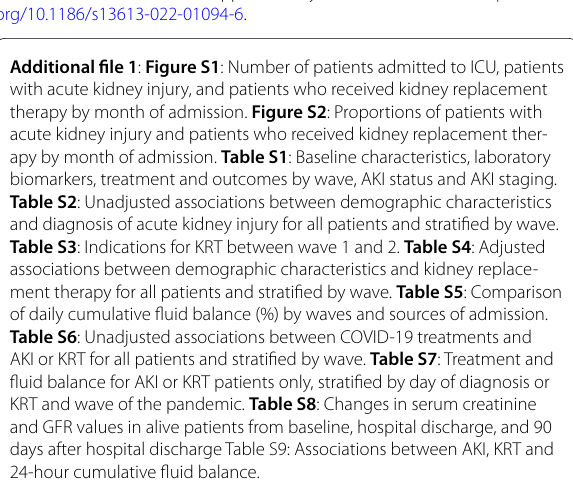
Table S6 : Unadjusted associations between COVID-19 treatments and AKI or KRT for all patients and stratified by wave. Table S7 : Treatment and fluid balance for AKI or KRT patients only, stratified by day of diagnosis or KRT and wave of the pandemic. Table S8 : Changes in serum creatinine and GFR values in alive patients from baseline, hospital discharge, and 90 days after hospital discharge Table S9: Associations between AKI, KRT